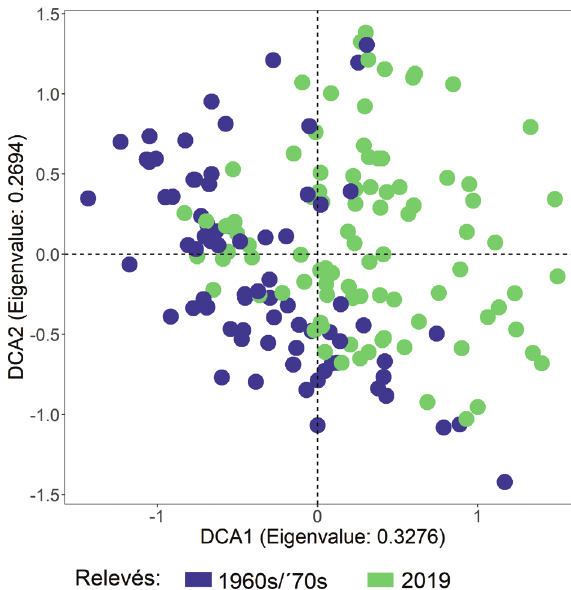
Figure 9. Ordination (DCA) of the old relevés (1960s / ´70s) and new relevés